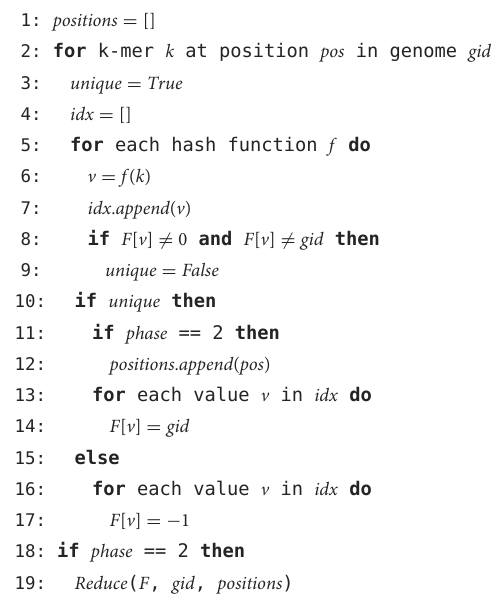
Algorithm 1. ProcessGenome( F , gid , phase ).